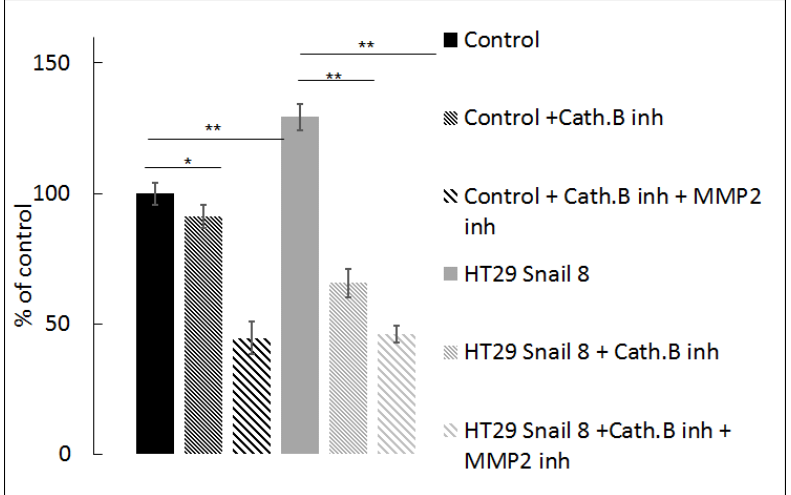
Figure 7. Effect of cathepsin B inhibition on gelatine degradation mediated by HT-29 cells with Snail overexpression. Cells were seeded on FITC conjugated-gelatine and incubated 24h in the presence of 100 µ M CA-074Me, inhibitor of cathepsin B or combination of 100 µ M CA-074Me and 10 µ M ARP10, MMP-2 inhibitor. Next, cells were analyzed by measurement of increase in FITC fluorescent intensity relativized to control cells treated as 100%. ** p > 0.005; * p > 0.05.